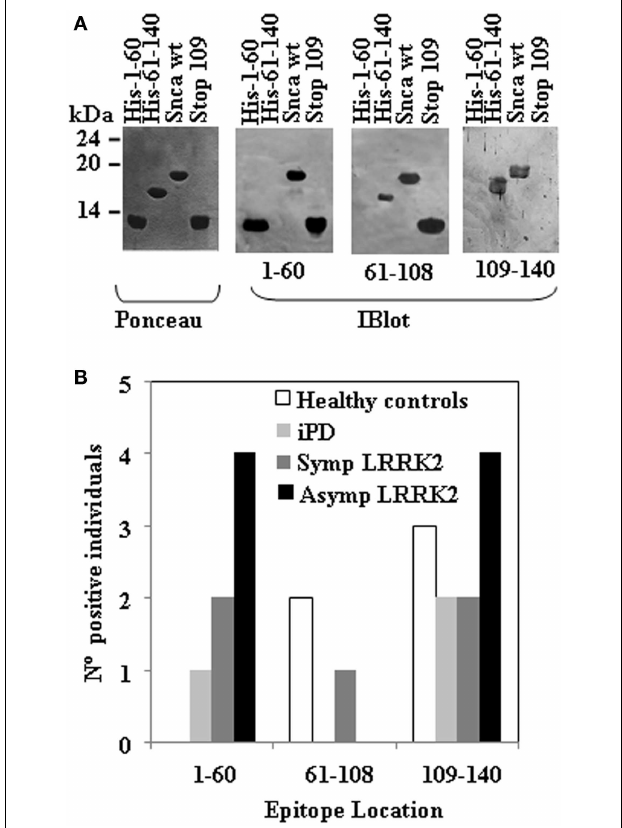
FIGURE 2 | Epitope mapping of anti-Snca human antibodies . (A) The blots of the different purified Snca constructs (Ponceau) used to characterize the epitopes of anti-Snca antibodies and examples of the different types of results obtained. Plasma that contained antibodies that recognize His-Snca 1–60, Snca full length and Snca 1–108 (Stop 109), but not His-Snca 61–140 and accordingly, their main epitope must be located at the N-terminus